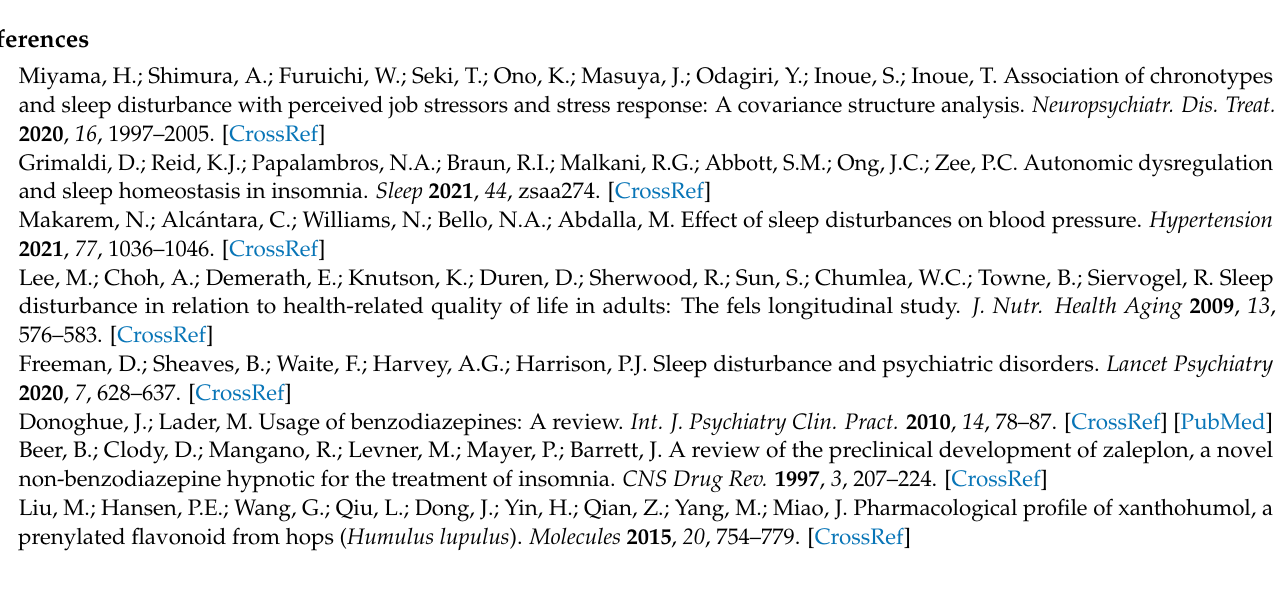
Figure S5: HPLC chromatograms of (A) standard GABA, (B) Saaz extract treated group, (C) Saphir extract treated group, and (D) Saaz-Saphir mixture treated